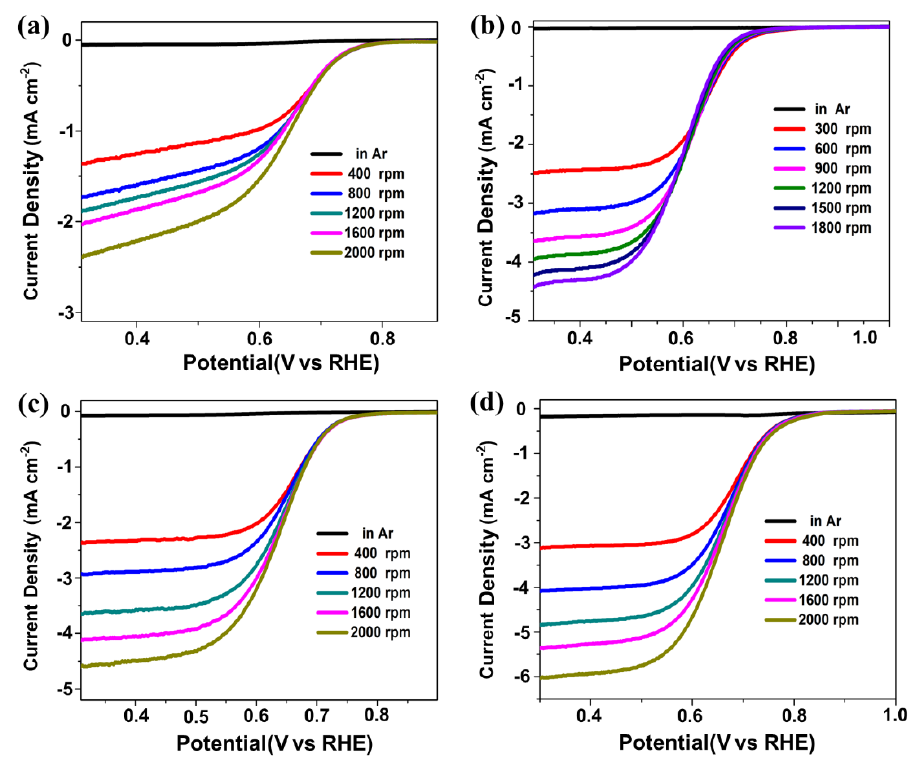
Figure 7. Linear sweeping voltammograms of ORR on ( a ) ZIF-8; ( b ) pristine γ -MnO 2 ; ( c ) ZIF-8@ γ -MnO 2 ; and ( d ) MnO x @C-N at different rotating rates.